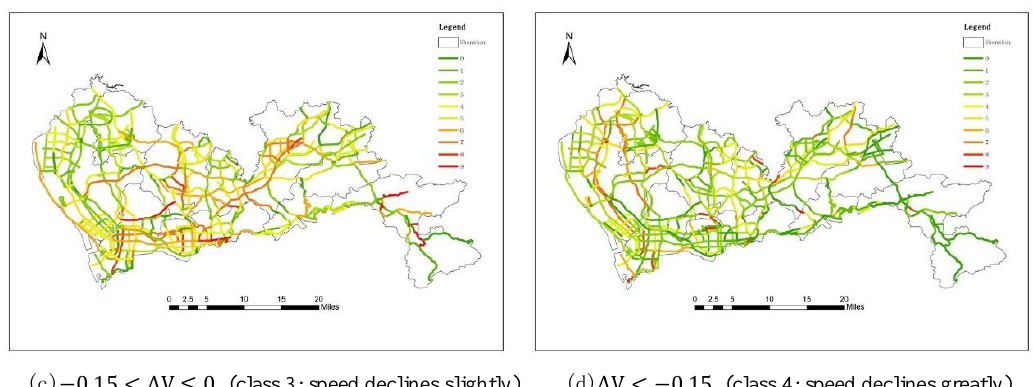
Figure 3. Road speed variation classification ( the other